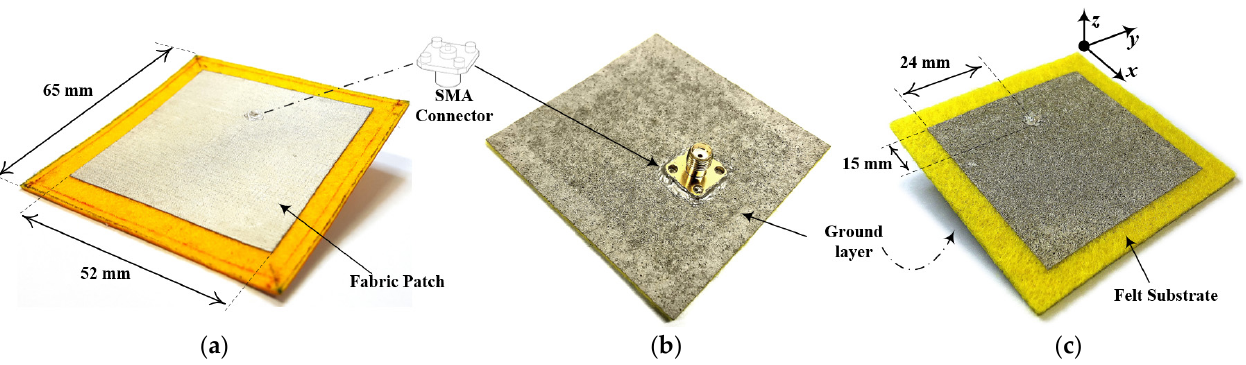
Figure 2. Fabricated antennas showing ( a ) top view of probe-fed patch antenna with conductive polyester base fabric, ( b ) back view of direct printed probe-fed antenna showing SMA attachment ( c ) top view probe-fed antenna with direct printed silver ink.